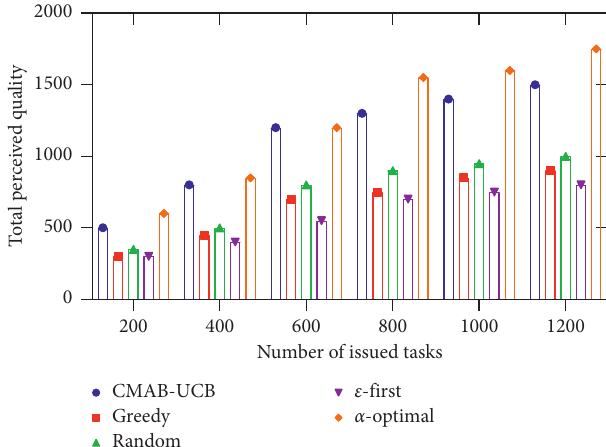
Figure 10: The relationship between perceived quality and the number of posting tasks ( b � 10000).